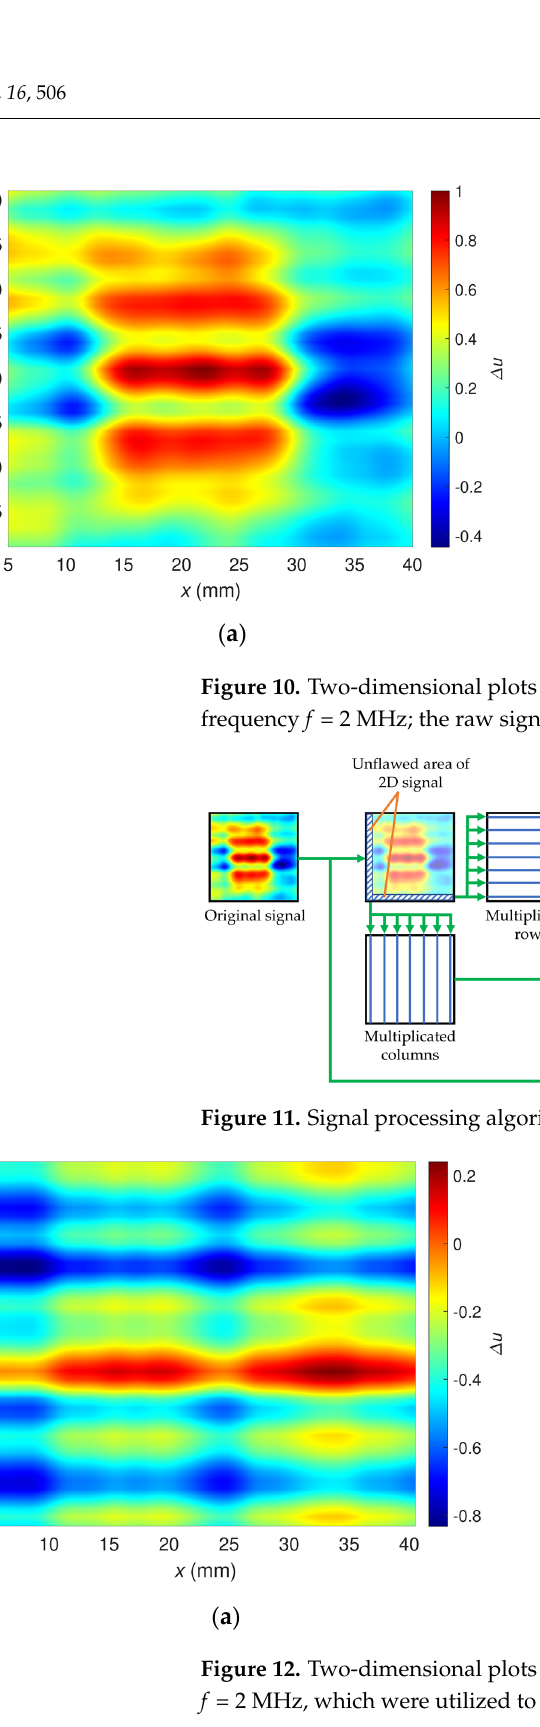
Figure 13. Two-dimensional plot of the relative voltage after background removal; excitation frequency f = 2 MHz.